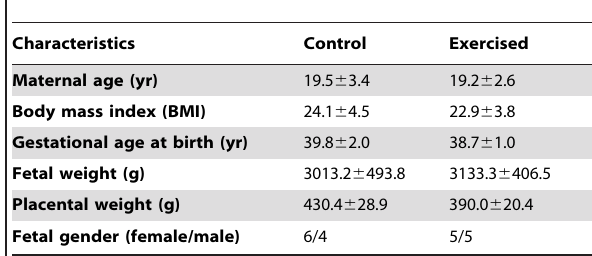
Table 1. Characteristics of the population: maternal age, BMI, gestational age at birth, fetal and placental weight and fetal gender in